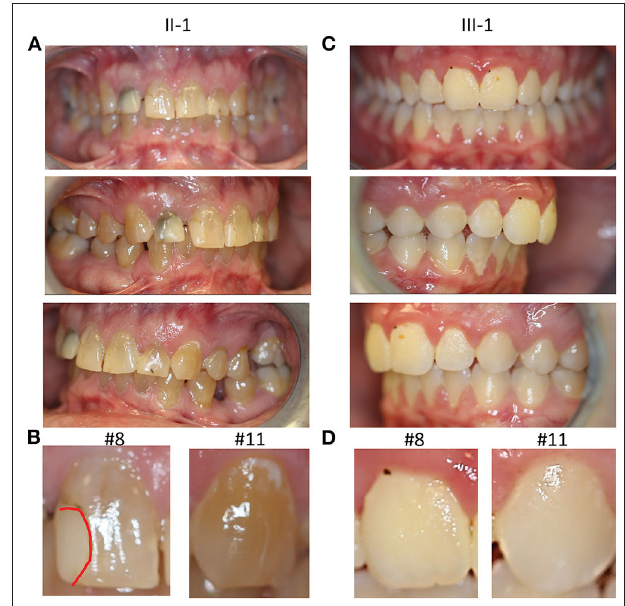
FIGURE 2 | Clinical oral manifestations. (A) Frontal, right lateral, and left lateral view of teeth showing tooth discoloration in proband II-1. (B) Magnified photos of tooth #8 and 11 with a red dotted line showing demarcation of the restoration on #8. (C) Frontal, right lateral, and left lateral view of teeth in the son of the proband III-1 (D) Magnified views of tooth #8 and 11 in III-1, showing normal appearance of